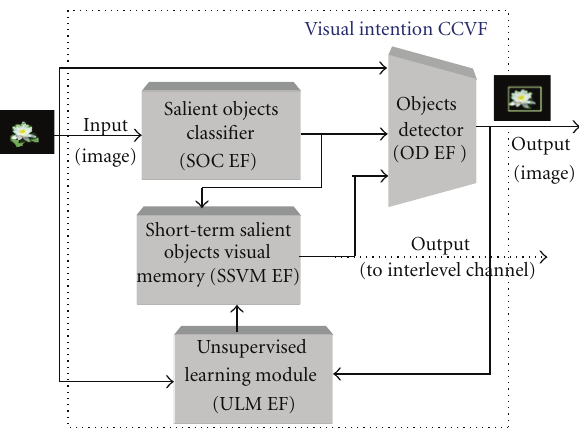
Figure 8: Bloc diagram of visional intention